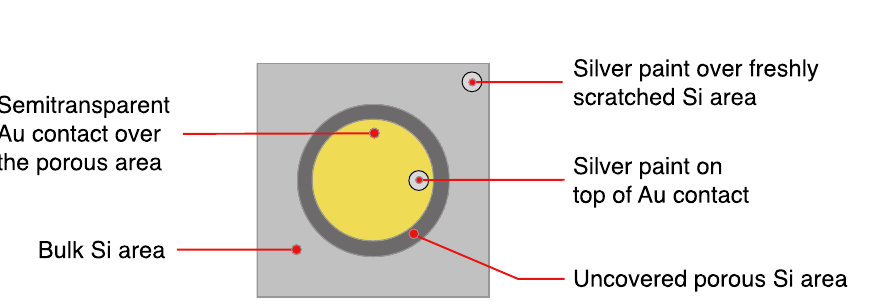
Figure 3. Schematic of a PSi sample ready for the photocurrent measurements. The various elements are